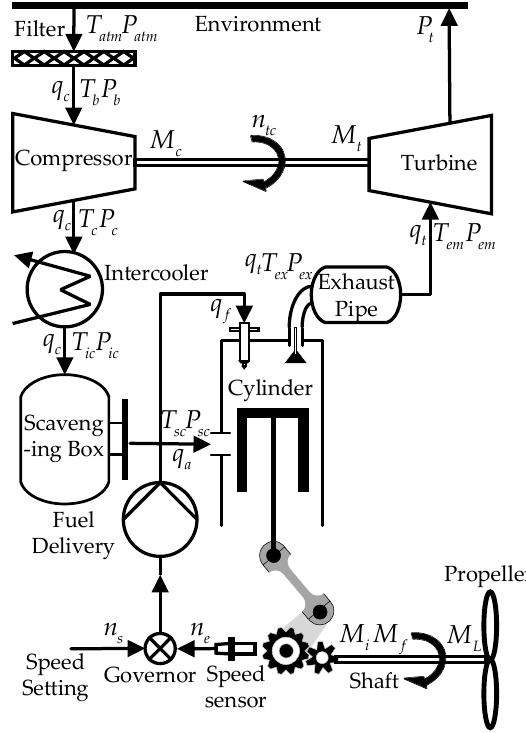
Figure 1. Schematic diagram of modeled diesel engine.